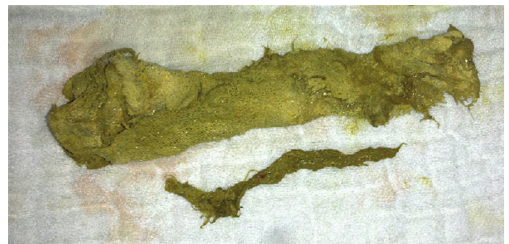
Figure 3: An opened form of sponge extracted from